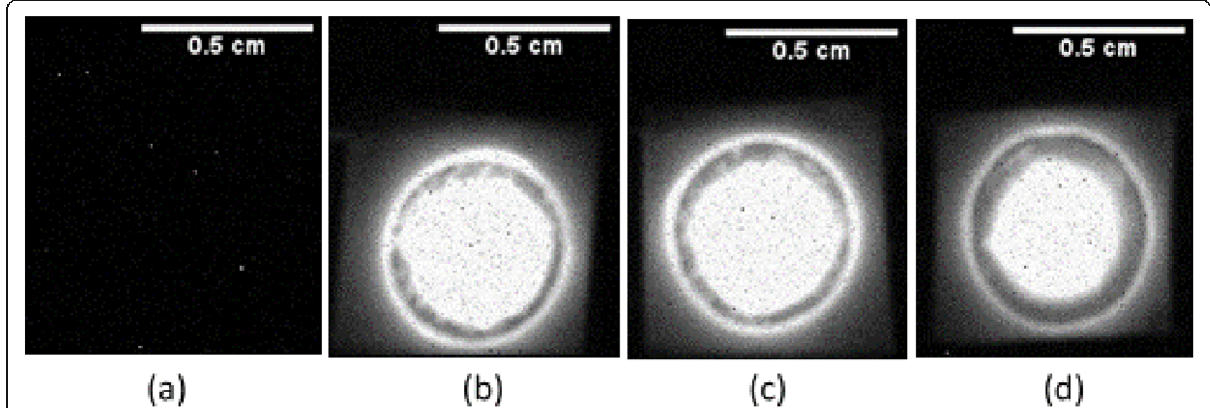
Fig. 4 Images of CL signal related to ferrocene tagged antibody, ( a ) characterise the ferrocene tagged antibody before ferrocene oxidation, ( b ) immediately after the oxidation, ( c ) 1-day oxidation ( d ) after 1-week oxidation. The scale bar is 0.5 cm.